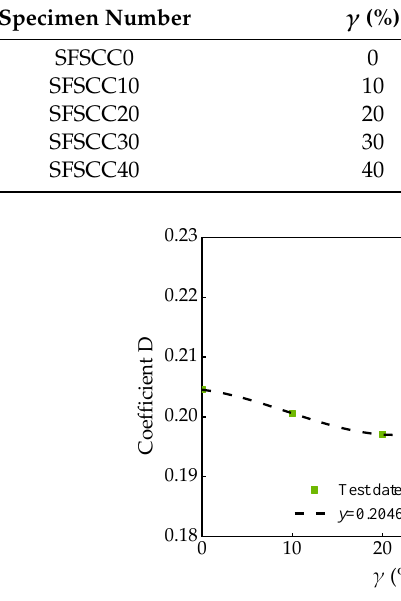
Figure 20. Relationship between coefficient D and substitution rate γ .